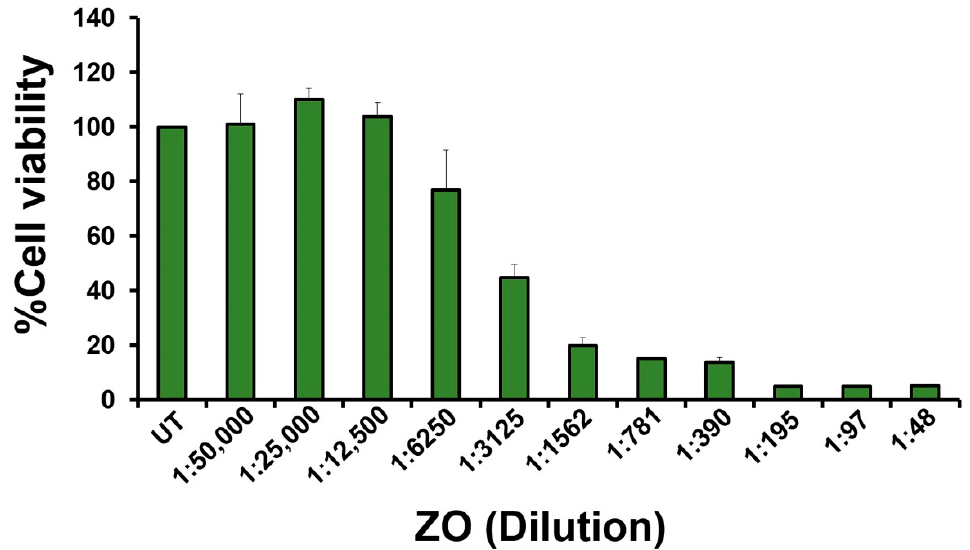
Figure 1. The effect of ZO essential oil on HeLa cell viability. The viability of HeLa cervical cancer cells upon being treated with ZO essential oil for 24 h was tested by an MTT assay. The treatment concentrations of ZO essential oil were prepared by performing a 2-fold dilution before addition to the cells. The experiment was performed three times (triplicate each time).